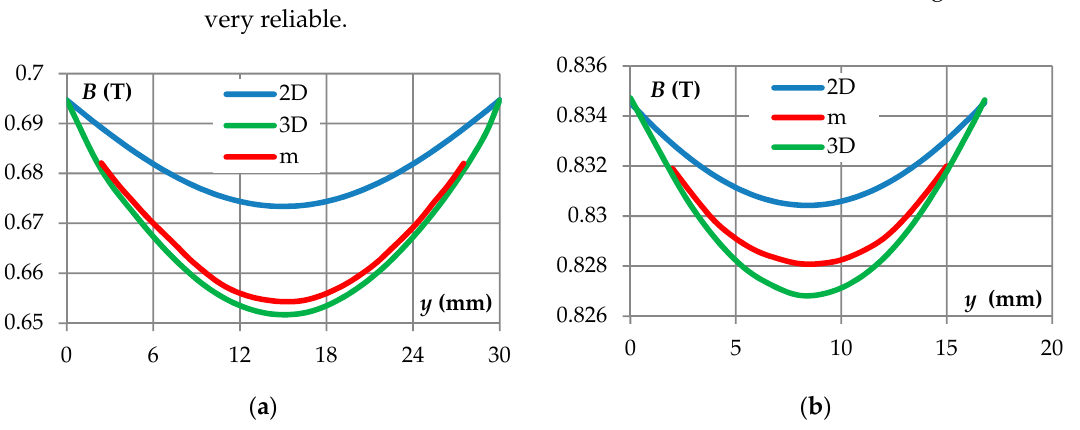
Figure 11. Magnetic flux density distributions along the exciter magnets for the gap: ( a ) δ = 21.3 mm and ( b ) δ = 12.5 mm, determined from measurements (m) and calculations at a distance from the surface of the lower magnet y = 4, 6, 12 mm.